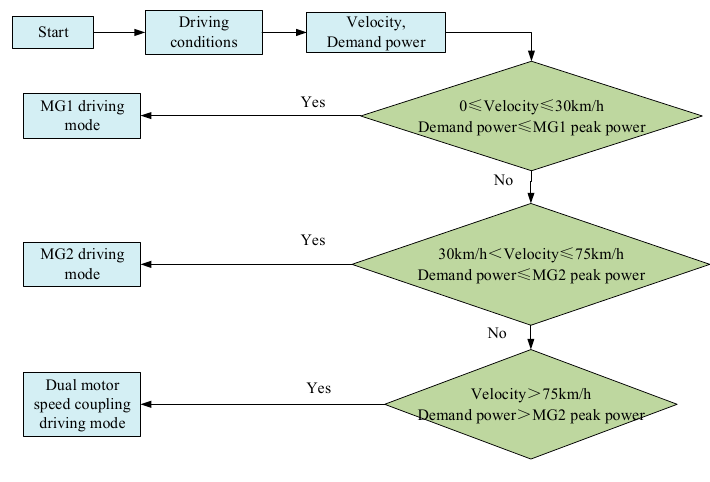
Figure 4. Mode shift strategy.